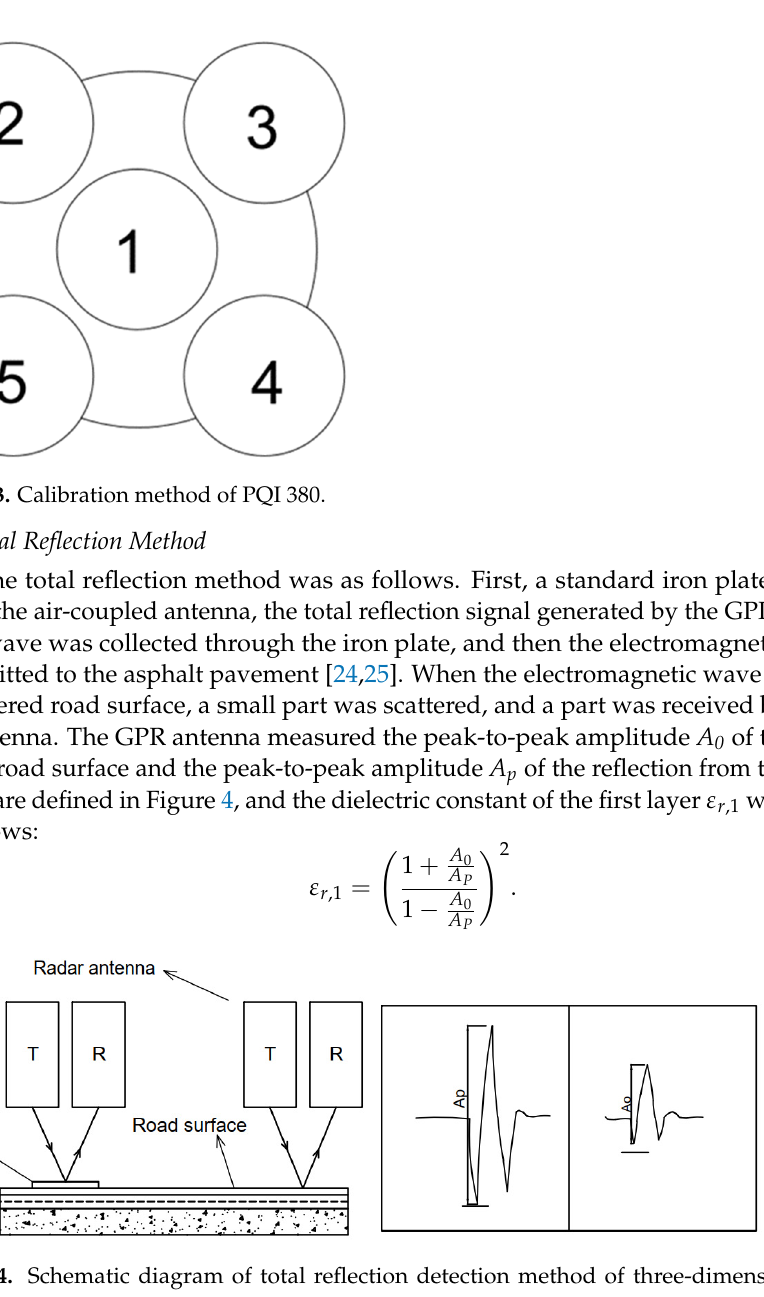
Figure 2. Non ‐ nuclear density gauge (PQI 380).